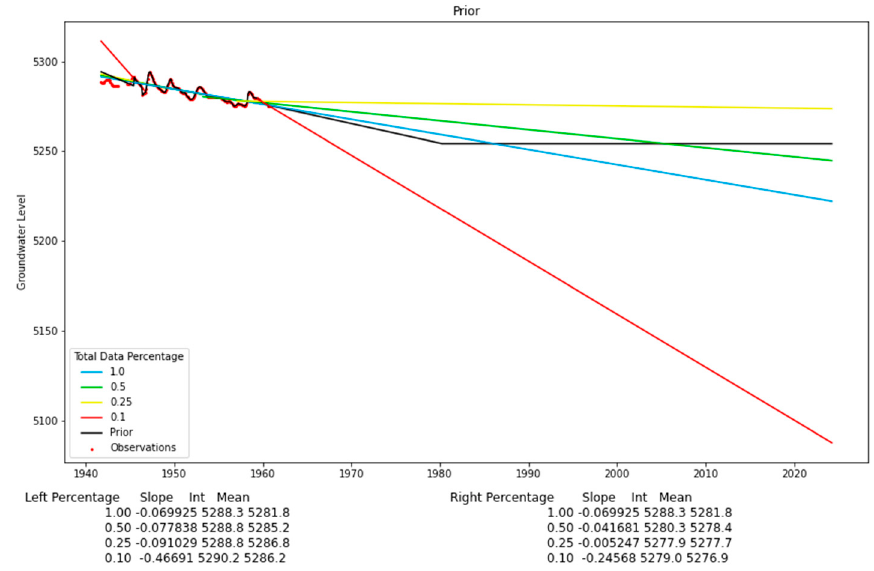
Figure 6. Prior for a well with a steep slope generated by interpolating and extrapolating the observed groundwater data.